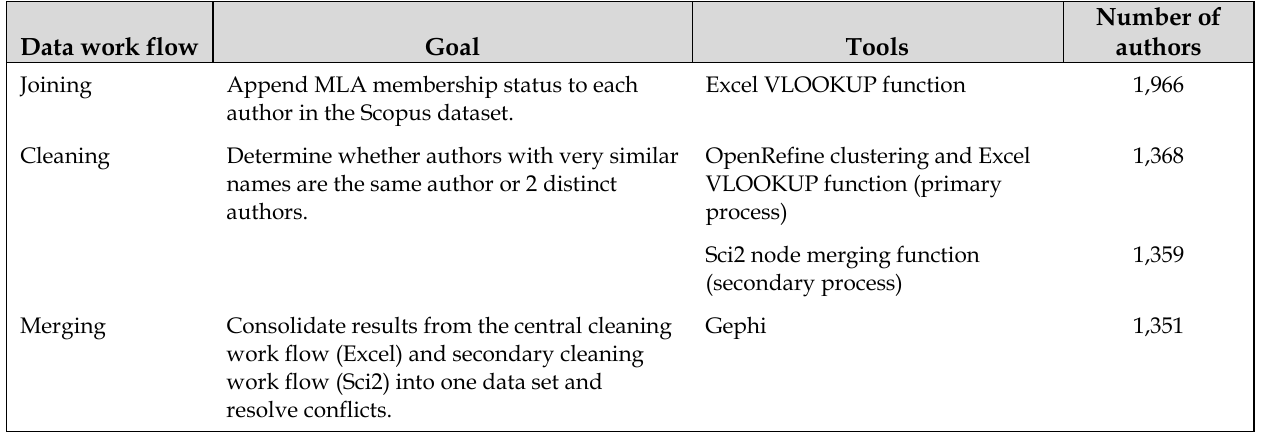
Table 1 Summary of data preparation